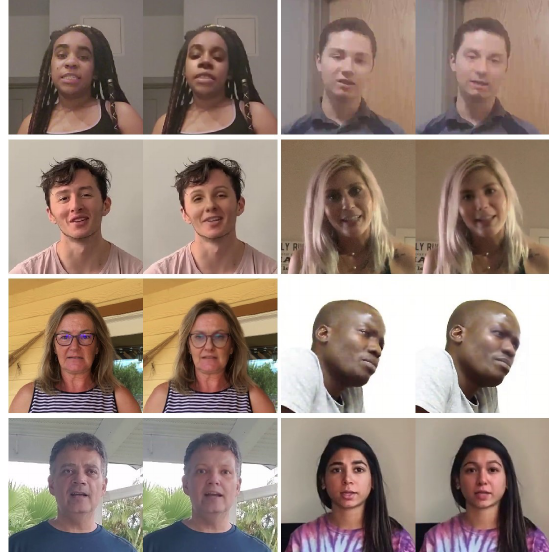
Figure 3. Deep-Fake Detection Challange Dataset [4]